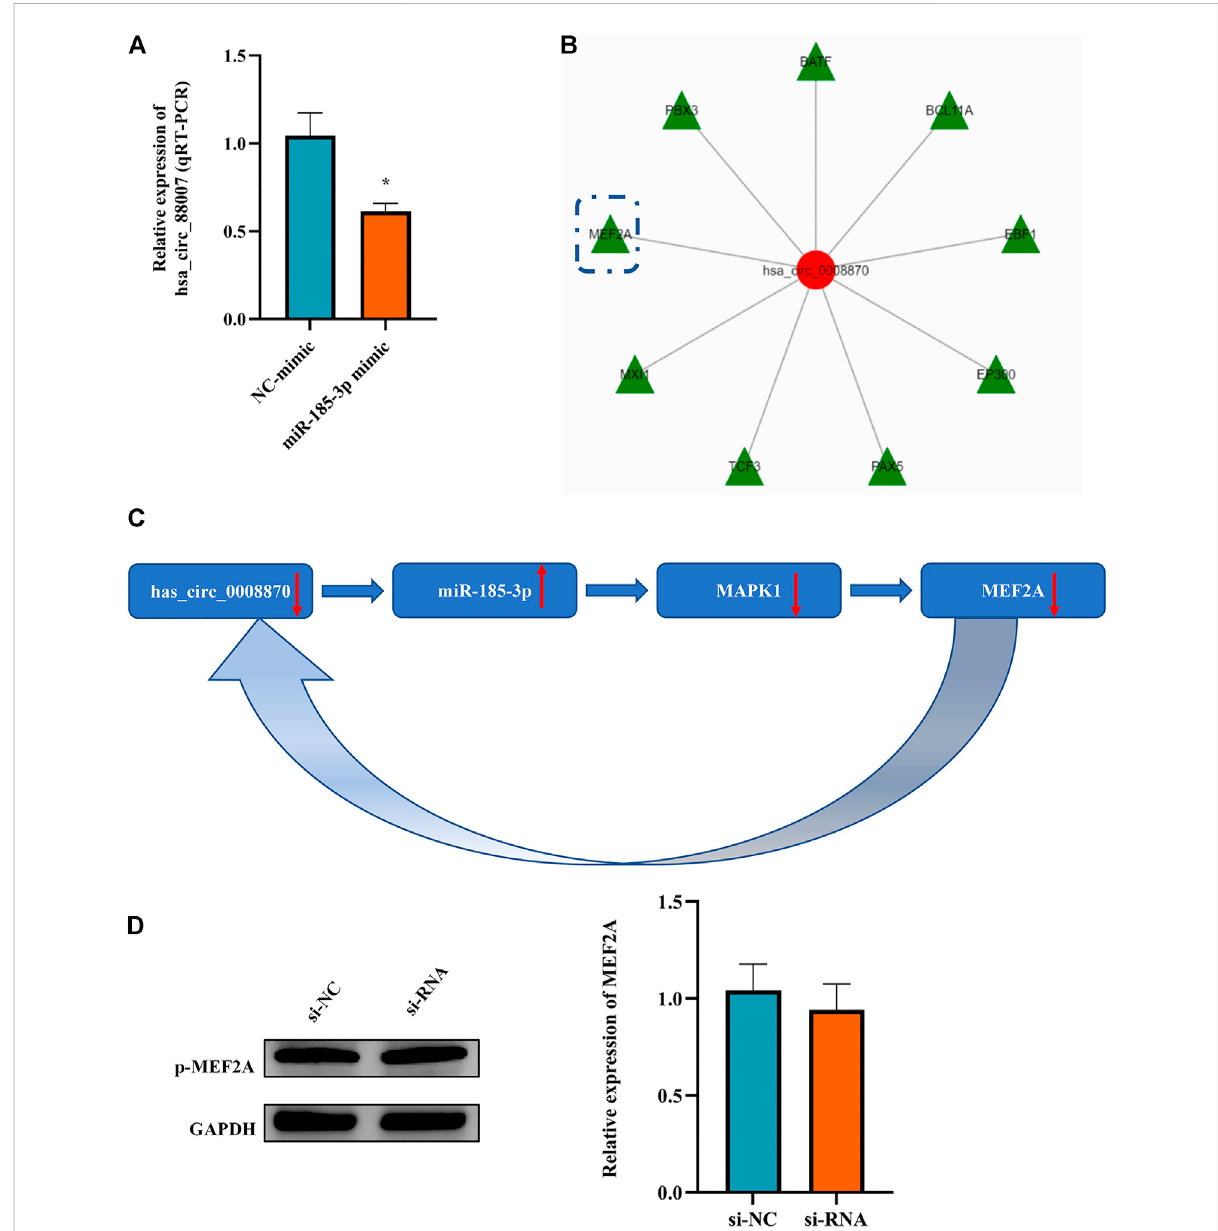
FIGURE 9 ThemiR-185-3pupregulationcaninhibittheexpression ofhsa_circ_0008870inchondrocytes viaapositive feedback loop. (A) The expression of hsa_circ_0008870 was assessed with miR-185-3p mimics. (B) Transcription factors of hsa_circ_0008870 were analyzed by bioinformatics. (C) The summary of the positive feedback regulation of hsa_circ_0008870/miR-185-3p/MAPK1/MEF2A loop. (D) The protein expressions